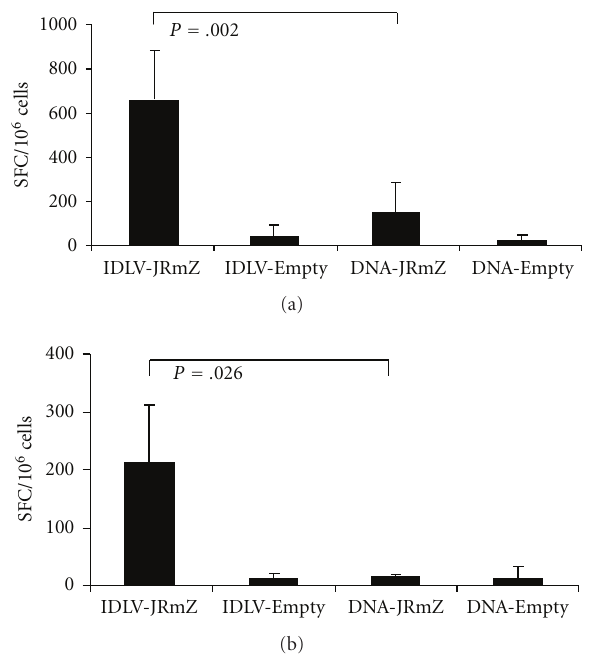
Figure 2: T cell responses measured on splenocytes (a) and BM- derived cells (b) at 90 days from immunizations. Results from one representative experiment out of three independent experiments are shown. IFN- γ ELISPOT was performed on cells stimulated overnight with either H-2 d restricted specific Envelope JR-9mer peptide or H-2 d restricted unrelated GFP-9mer peptide. IFN- γ producing T cells are expressed as SFC/10 6 cells after background subtraction (see Section 2). The error bars indicate the standard deviation among four mice of the same group, and P -values are indicated for intergroup